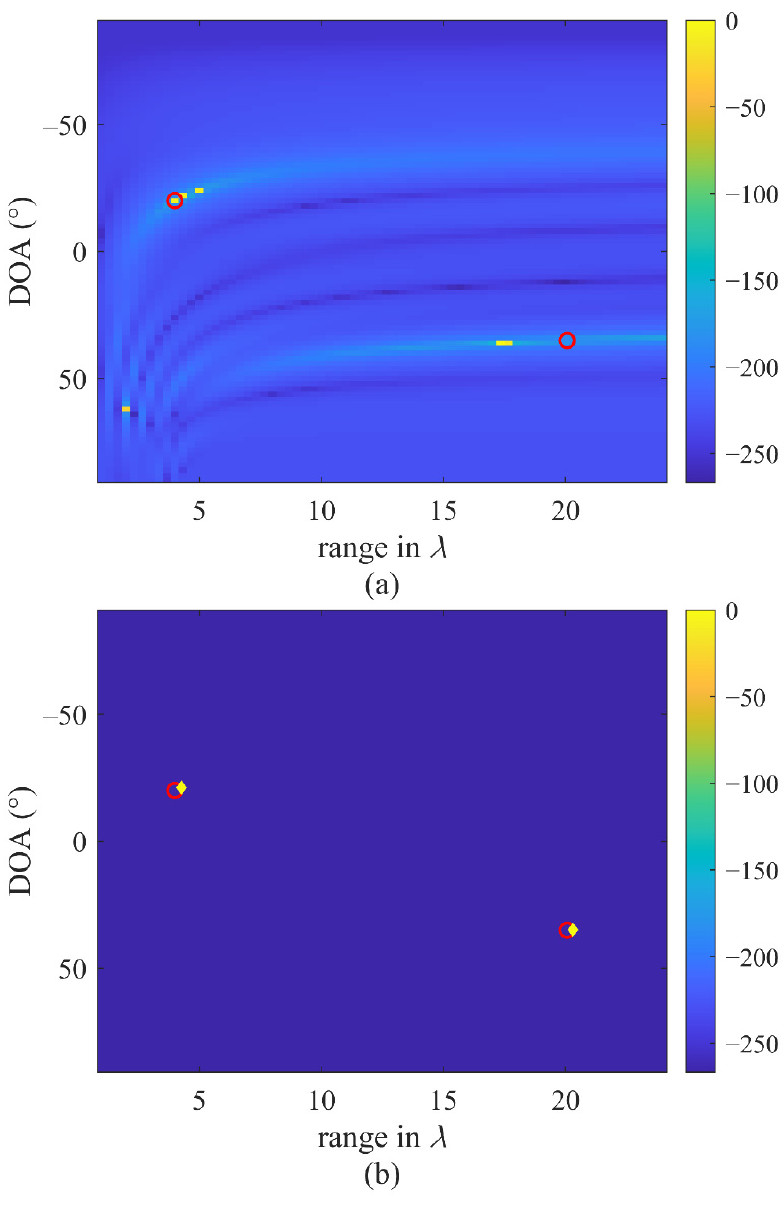
Figure 6. Two near-field sources localization results and the actual positions (red circle): ( a ) The power estimation at the grid of DOA and range by the CS-based method, ( b ) The DOA and range estimation by the CVMD-based method (yellow rhombus).